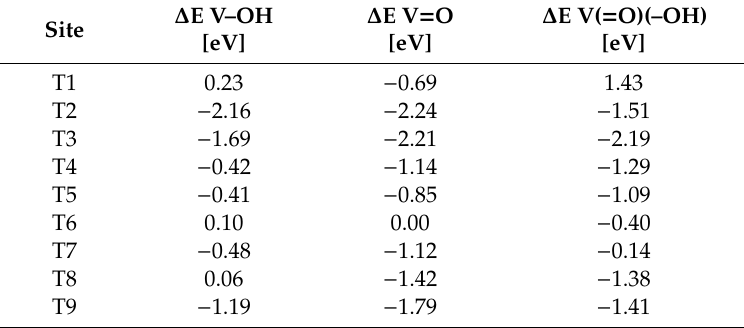
Table 1. Energy (in eV) needed for the isomorphic substitution of the zeolite Si atom into V–OH, V = O, and V( = O)(–OH)